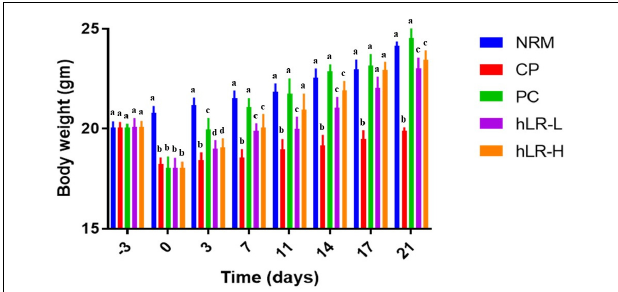
FIGURE 4 | Effects of hLR on the body weight in CP-treated mice. Data are the mean ± SEM ( n = 8). Values with different letters indicate a significant difference between the groups in the same time point ( p < 0.05).